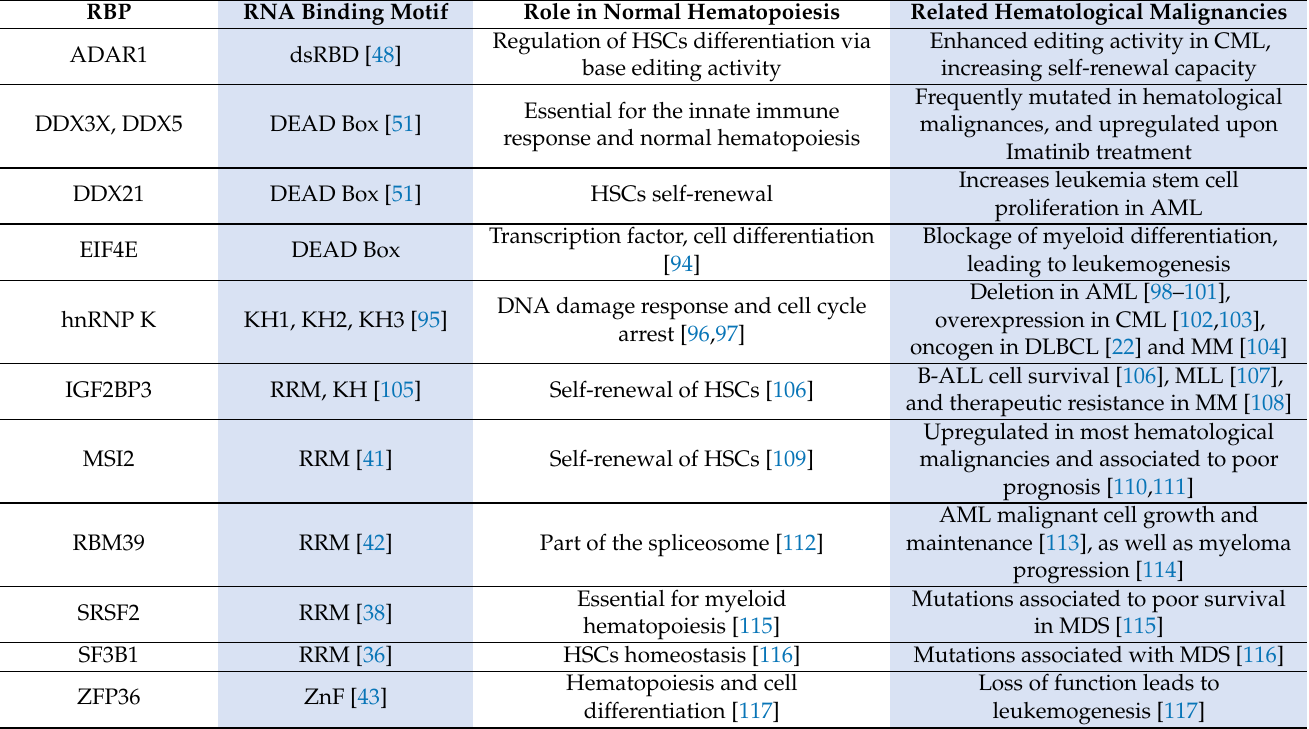
DNA damage response and cell cycle